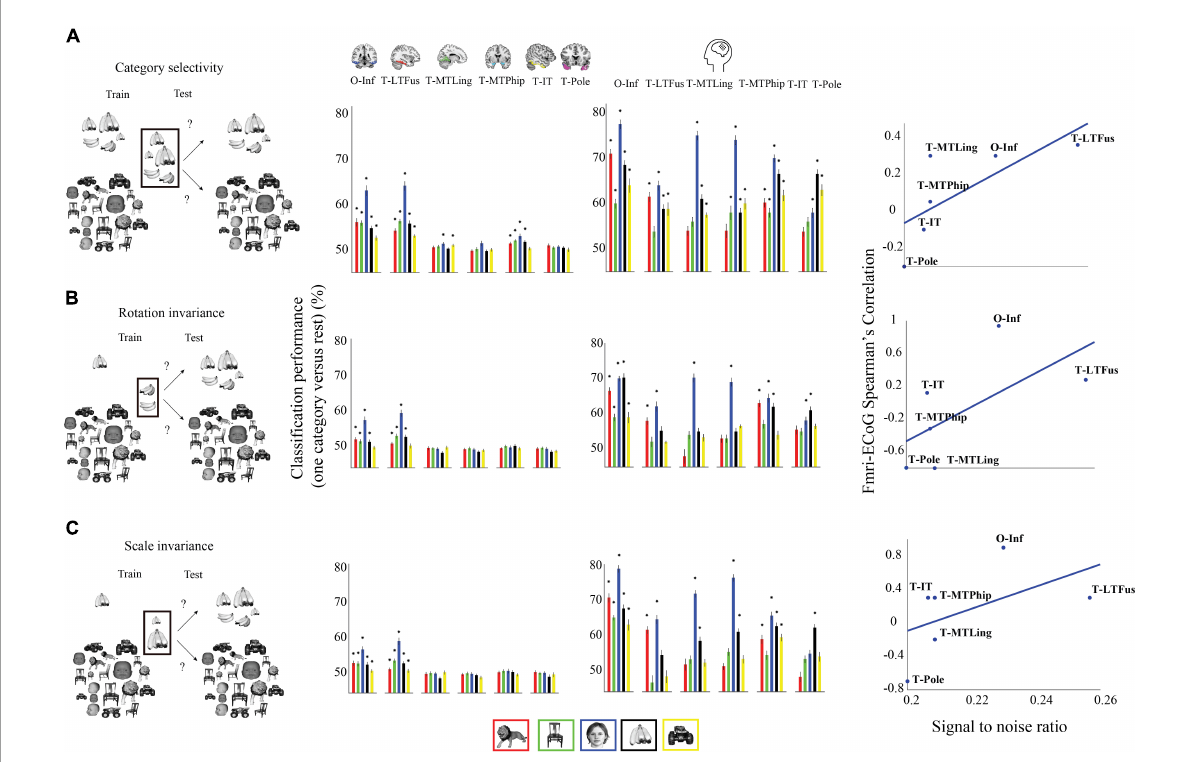
FIGURE4 Classification performance (one category vs. rest) for the classification schemes (A) category selectivity, (B) rotation invariance, (C) and scale invariance. First column: cartoon visualization of stimuli for data used to train and test the classifier in each analysis scheme. Second column: region-specific classification results for (average performances across 21 participants). Third Column: region-specific classification results for ECoG. Error bars indicate one standard deviation, and stars above bars indicate statistical significance (fMRI: bootstrap test of 21 participants with 10,000 repetitions, FDR-corrected at p < 0.05. ECoG: permutation test over stimuli, not corrected). Fourth Column: correlation between signal-to-noise ratio in fMRI and ECOG classification results in the category selectivity scheme across regions. The ROIs include occipital-inferior (O-Inf), fusiform (T-LFus), lingual (T-MLing), parahippocampal (T-MTPhip), inferior-temporal (T-IT), and pole-temporal cortex